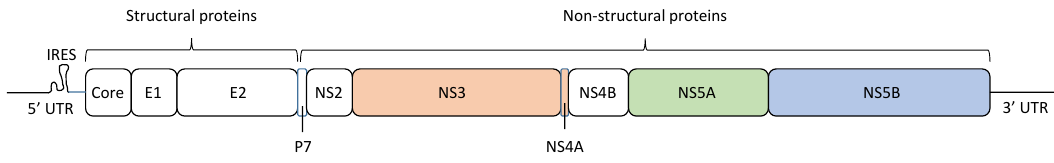
Figure 1. Hepatitis C virus (HCV) genome structure. The HCV RNA genome encodes a protein of ~3000 amino acids in length, which is cleaved to generate three structural proteins (core, E1, and E2) and seven non-structural (NS) proteins (p7, NS2, NS3, NS4A, NS4B, NS5A, and NS5B). In this figure, the amino acid positions of these proteins are mapped, and the 5’ untranslated region (5’-UTR) and 3′ untranslated region (3’-UTR) are indicated. Approved antiviral agents directly target NS3/4A, NS5A, and NS5B for effective inhibition of HCV replication.